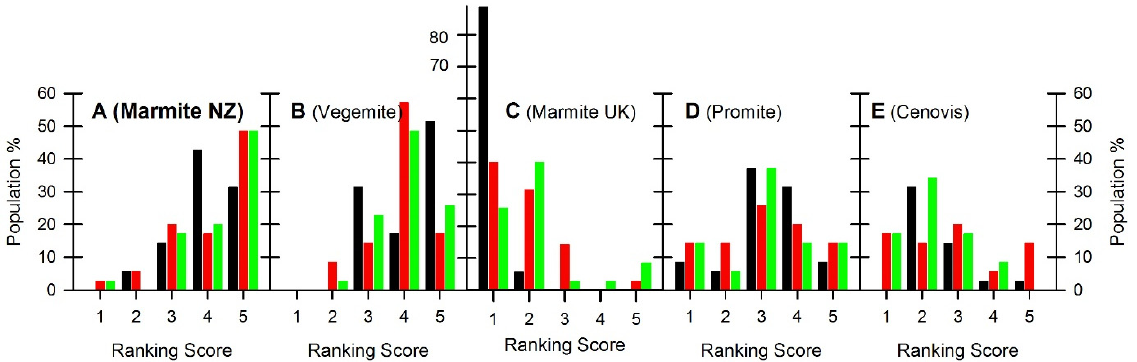
Figure 3. Ranking of yeast spreads in an impromptu sensory session in New Zealand ( n = 70). ( A ) ranking received by the New Zealand Marmite (in bold); ( B ) rankings received by Vegemite; ( C ) rankings received by the UK Marmite; ( D ) ranking received by Promite; and ( E ) rankings received by Cenovis. Rankings ranged from 1 to 5 as from low to high. Black bars represent the sensory perception based on sight only. Red bars represent the sensory perception based on smell only. Green bars represent the sensory perception based on taste only. Friedman ranking tests for all three attributes returned p < 0.01.